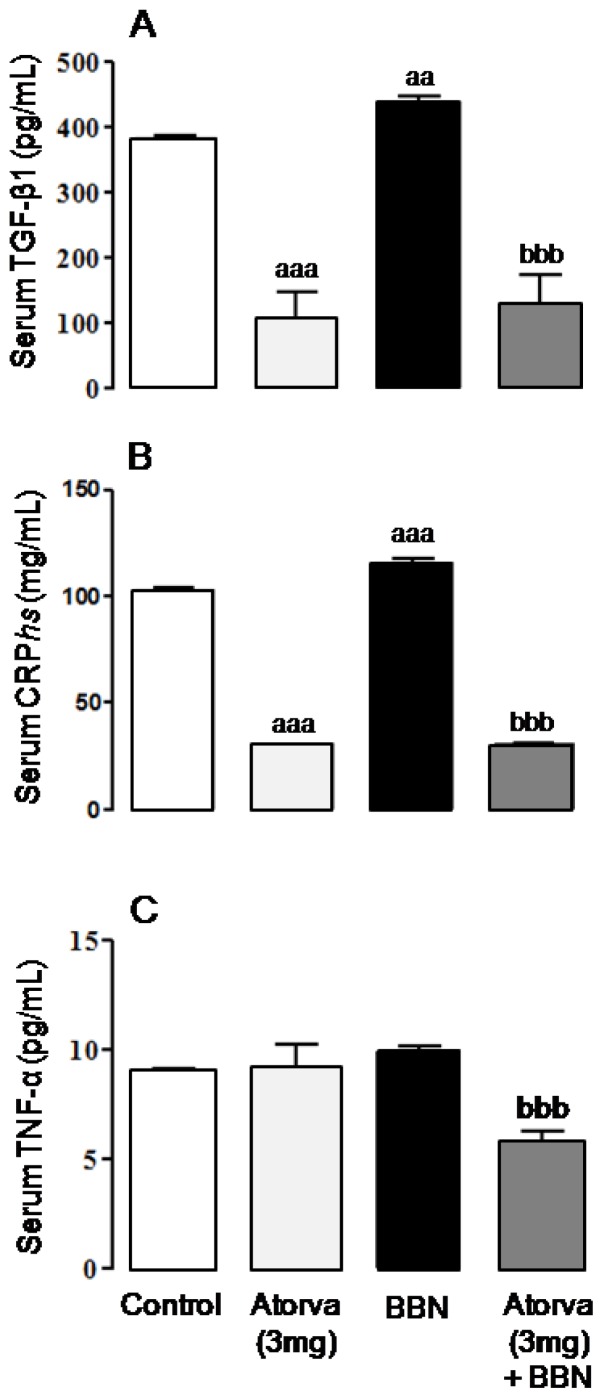
Serum markers of proliferation and inflammation. (A) TGF-β1; (B) CRPhs; (C) TNF-α. Values are mean ± SEM. a: p < 0.05 and aaa: p < 0.001 vs. Control group; bbb: p < 0.001 vs. BBN group.